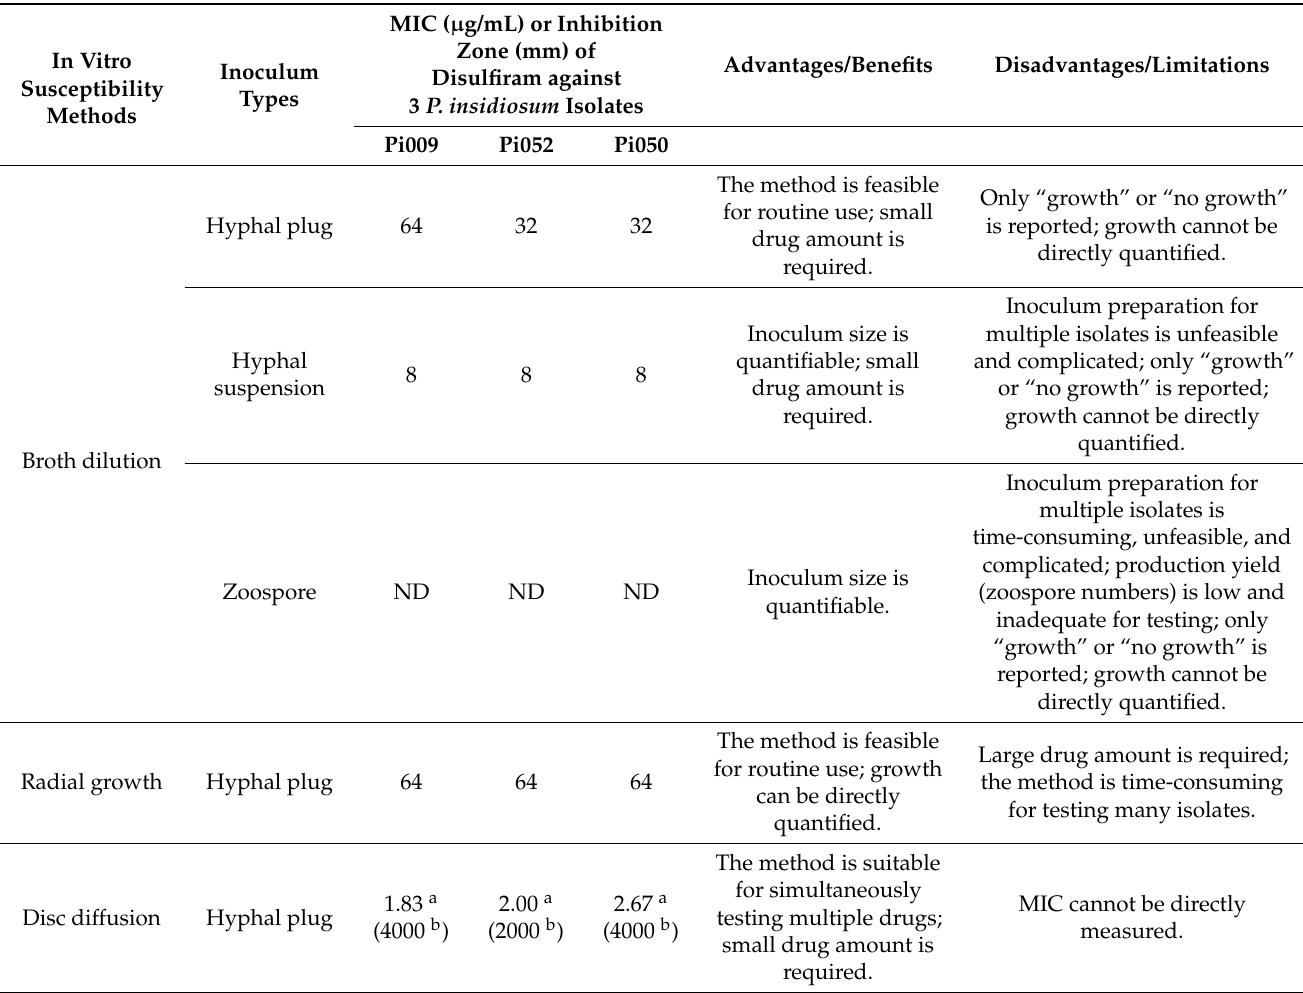
Table 2. Side-by-side performance comparison of 3 in vitro drug susceptibility methods and 3 inoculum types for assessing anti- P. insidiosum activity of disulfiram. Abbreviations: MIC,